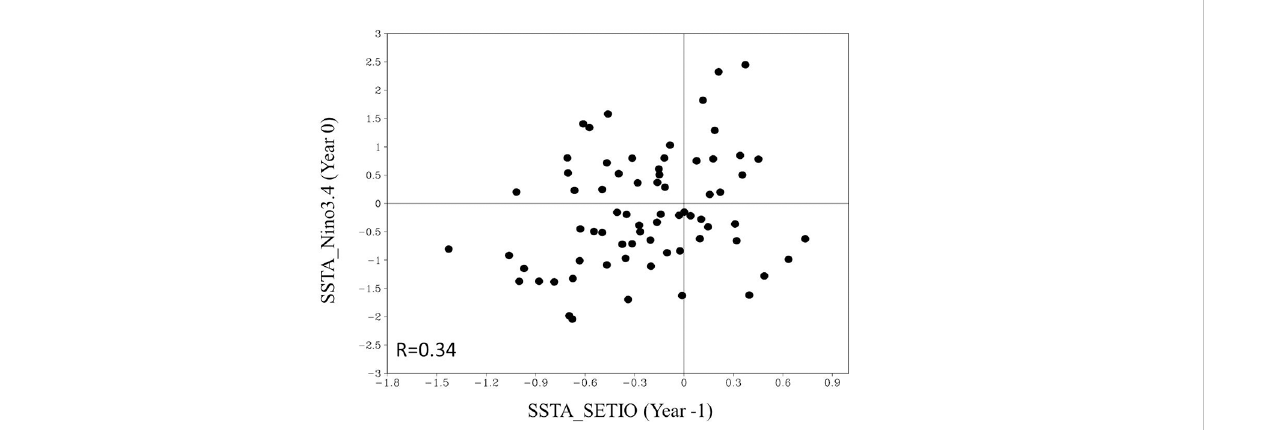
FIGURE 14 Application of the statistical model to longer SSTA time series. Scatter plot of the fall Niño3.4 index with the SETIO SSTA in the preceding fall for the period of 1950-2020. Correlation coef fi cient in the third quadrant is shown in the lower left of this fi gure.